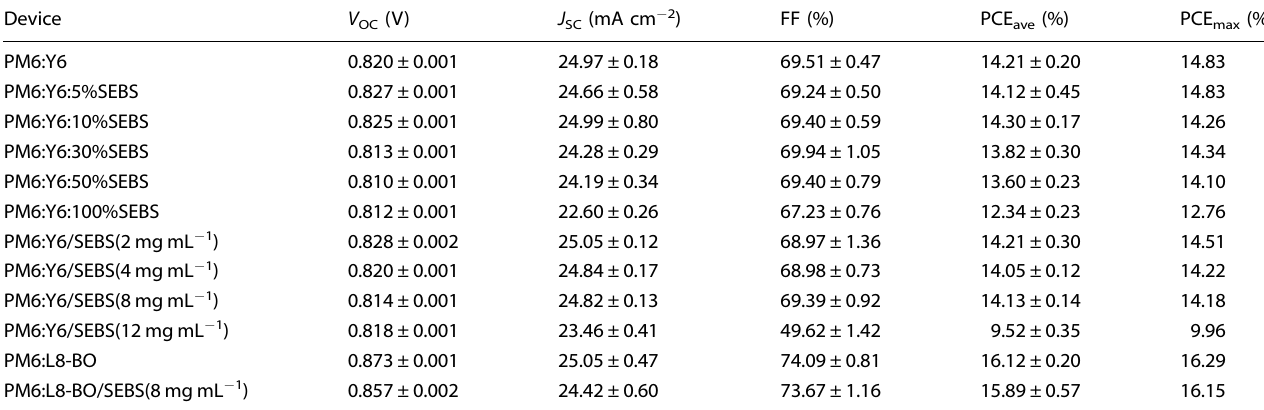
Table 1. Photovoltaic parameters of FOSCs with SEBS doped active layers or SEBS interface modi fi ed active layer.